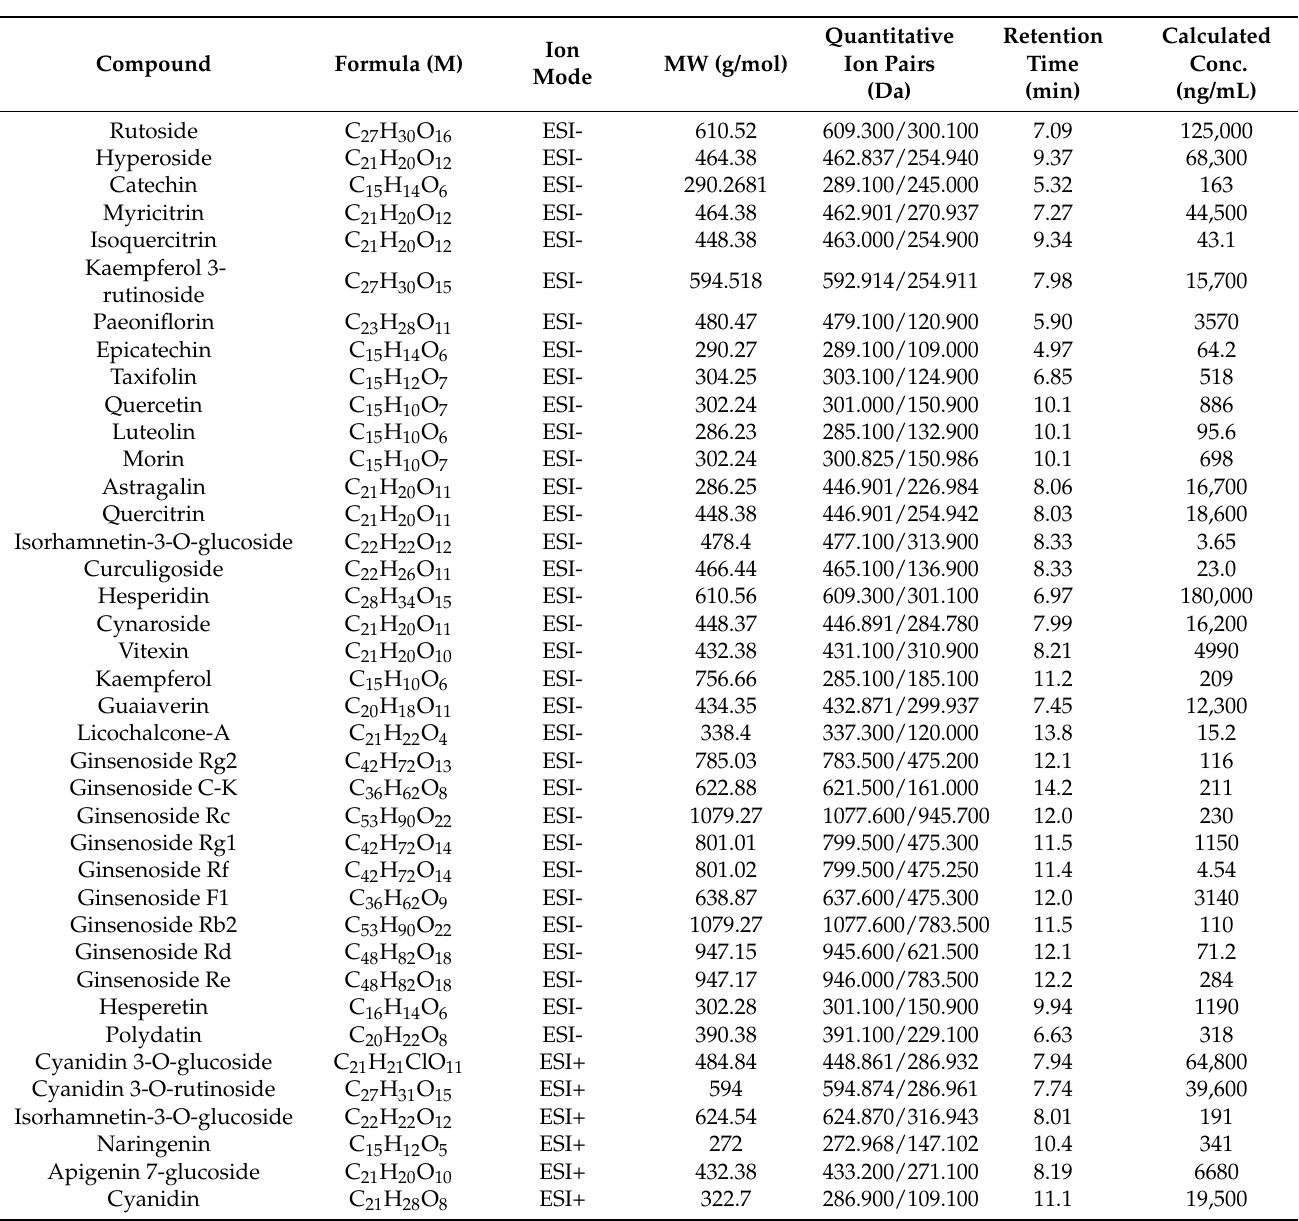
Table 1. Multiple reaction monitoring (MRM) details for liquid chromatography with tandem mass spectrometry (LC-MS/MS) estimation of FML from the analytical data of a biological